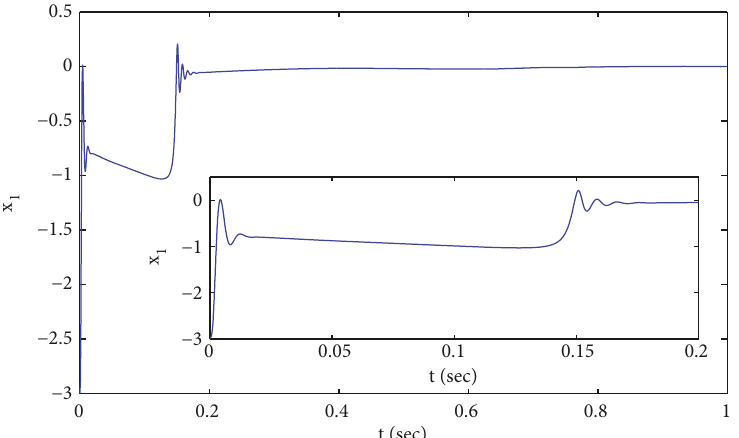
Figure 2: The time response of state 𝑥 1 of system (36) with controller